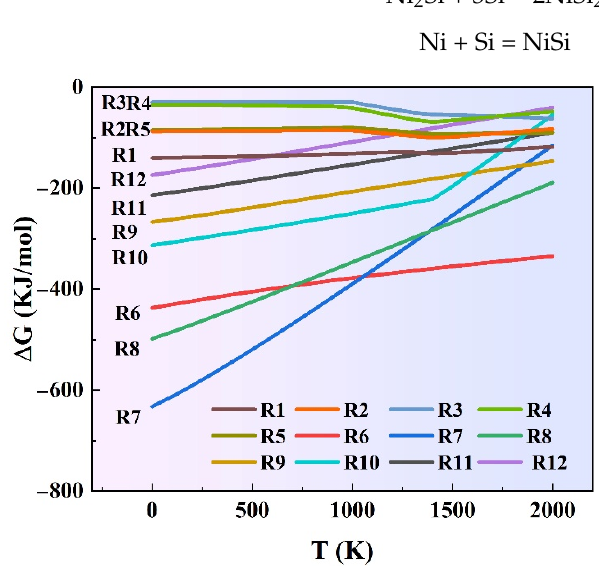
Figure 3. Gibbs free energy ( Δ G) of Reactions